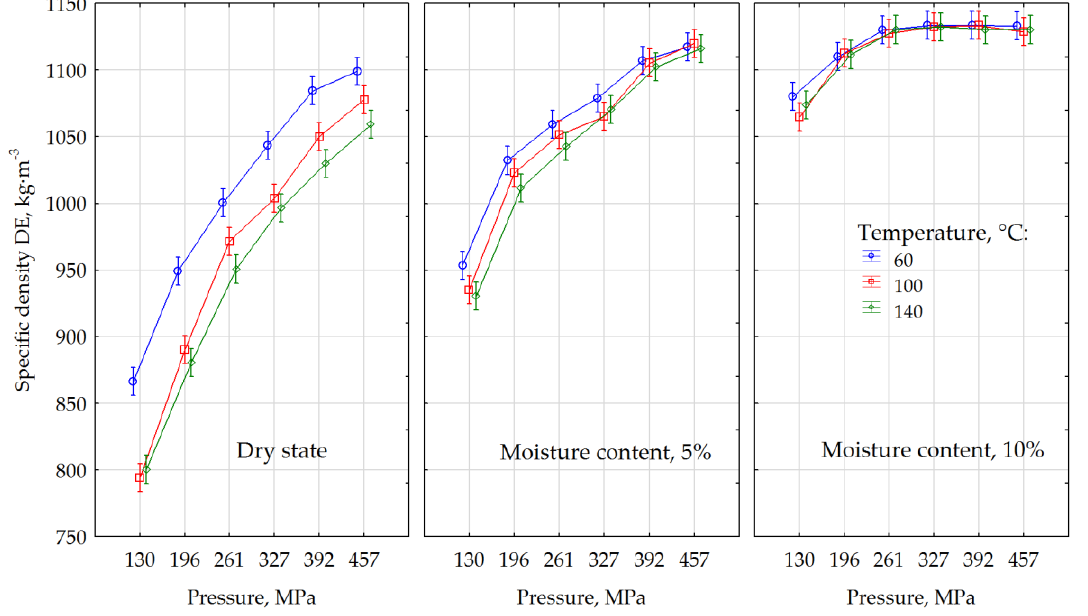
Figure 8. Changes in the specific density ( DE ) of the pellets as a function of the compaction process parameters.